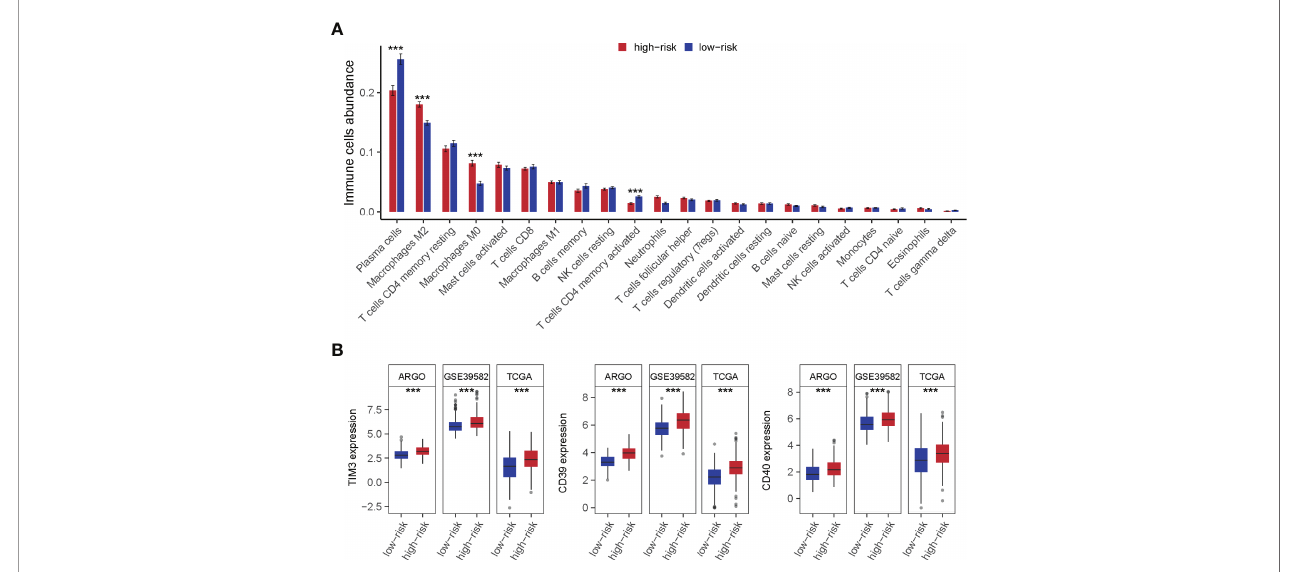
FIGURE 7 | Immune cell in fi ltration analysis of high-risk and low-risk groups. (A) The in fi ltration of 22 types of immune cells ’ abundance for high- and low-risk groups. The high-risk group was associated with decreased densities of plasma cells and CD4 memory-activated T cells. And low-risk patients tended to be in fi ltrated with fewer M2 and M0 macrophages, while no signi fi cant difference was found within other immune cell types. (B) TIM3, CD39, and CD40 were upregulated in the high-risk group. ***P <